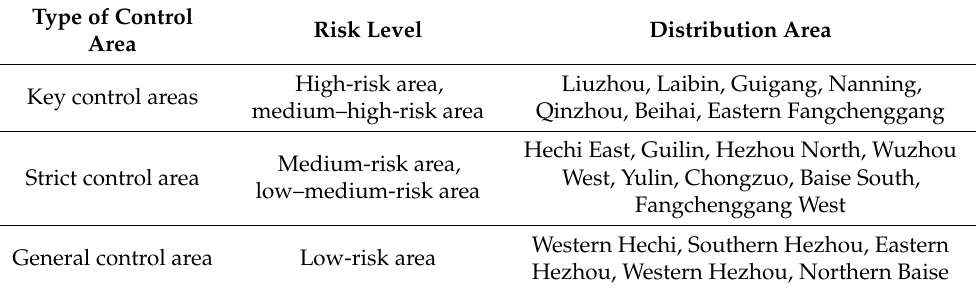
Table 6. Guangxi ecological risk control area